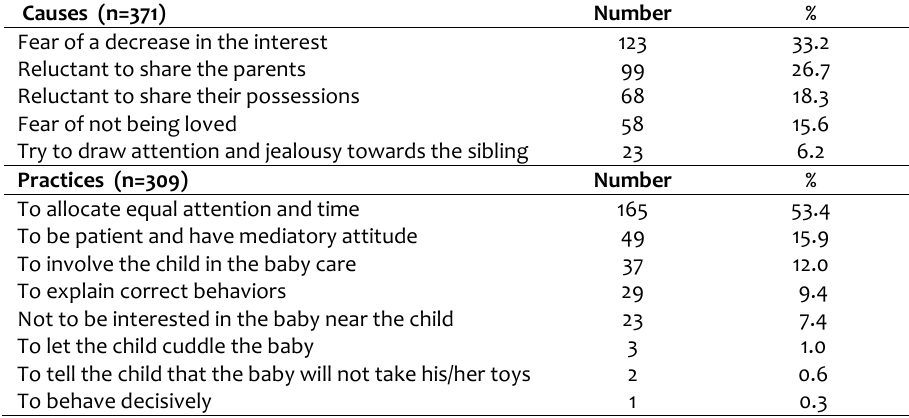
Gender Boy Birth order